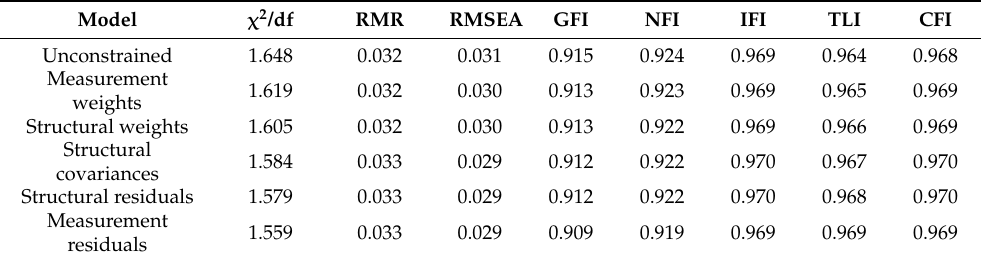
Table 7. Goodness results of fit indices.